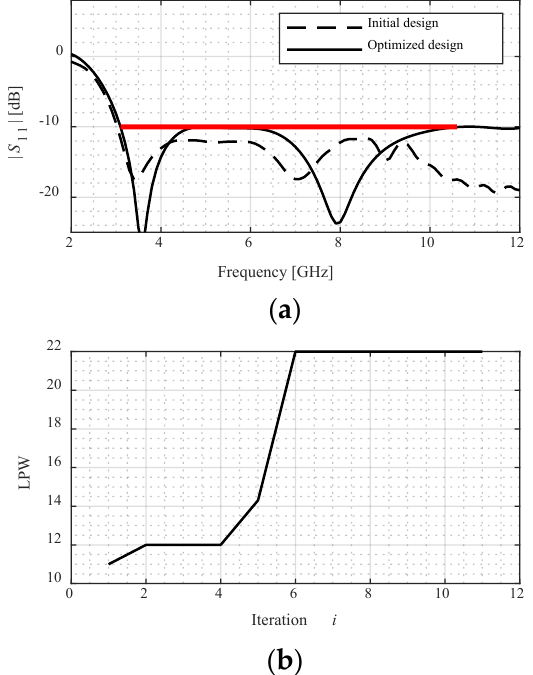
Figure 9. Numerical results obtained for Antenna III using the proposed algorithm incorporating multi-fidelity model management and adaptive penalty coefficients: ( a ) reflection responses, ( b ) evolution of the model fidelity. The horizontal line represents the design specifications.